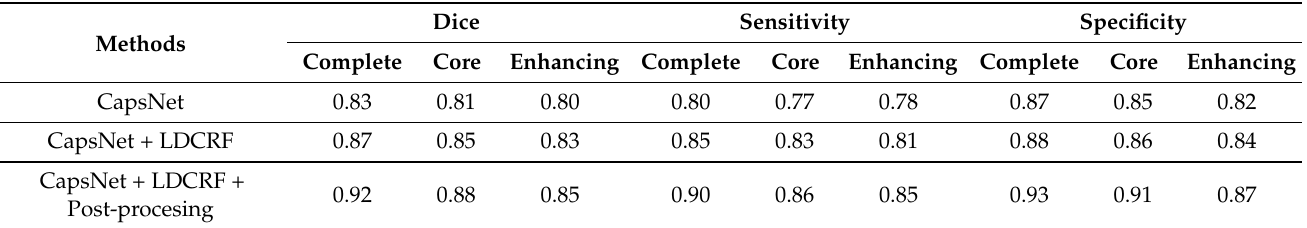
Table 5. In the MICCAI BRATS 2021 dataset, segmentation outcomes with respect to the Dice score, sensitivity, and specificity.